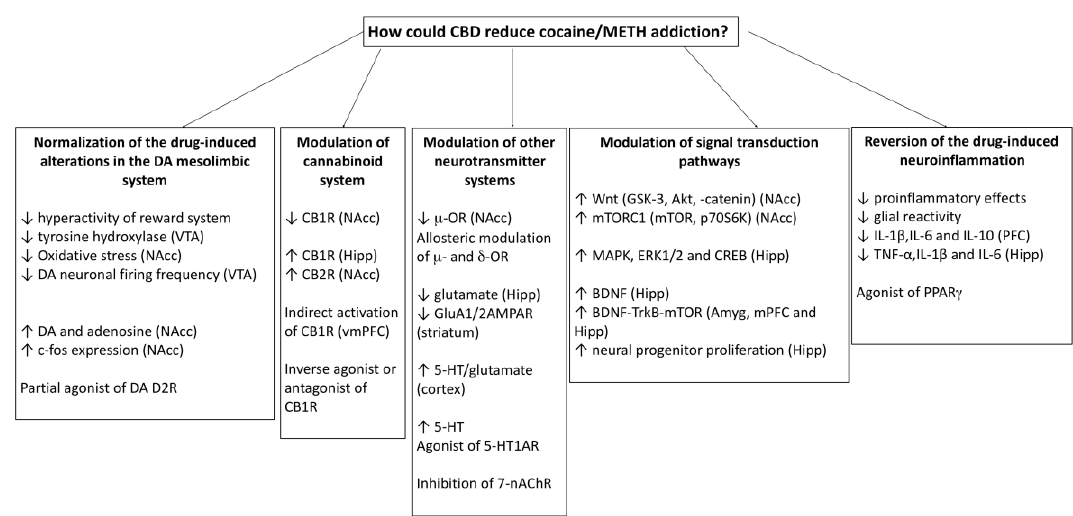
Figure 2. Hypothetical mechanisms involved in the e ff ects of CBD on cocaine / METH addiction. The involvement of these processes is supported by the results of preclinical studies. VTA: ventral tegmental area; DA: dopamine; NAcc: nucleus accumbens; DA D2: dopamine D2 receptors; CB1R; cannabinoid receptors type 1; Hipp: hippocampus; CB2R; cannabinoid receptors type 2; vmPFC: ventromedial prefrontal cortex; m-OR: mu opioid receptors; d-OR: delta opioid receptors; 5-HT: serotonin; 5-HT1AR: type 1A serotonin receptors; 7-nAChR: nicotinic acethylcholine receptors type 7; GSK3: glycogen synthase kinase-3; Akt: protein kinase B; mTORC1: mammalian target of rapamycin complex 1; MAPK, mitogen-activated protein kinase; ERK1 / 2: Extracellular signal-regulated kinases type 1 and type 2; BDNF: brain derived neurotrophic factor; TrkB: Tropomyosin receptor kinase B; Amyg: amygdala; mPFC: medial prefrontal cortex; IL: interleukine; TNF- α : tumor necrosis factor alpha; PPARg: Peroxisome proliferator-activated receptor